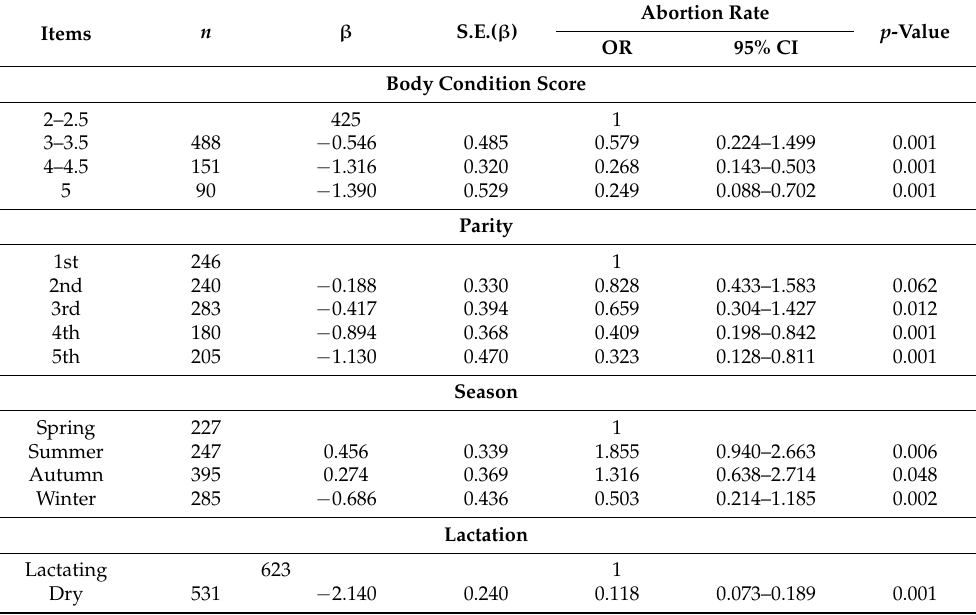
Table 2. Logistic regression analysis of risk factors associated with fetus abortion of Egyptian